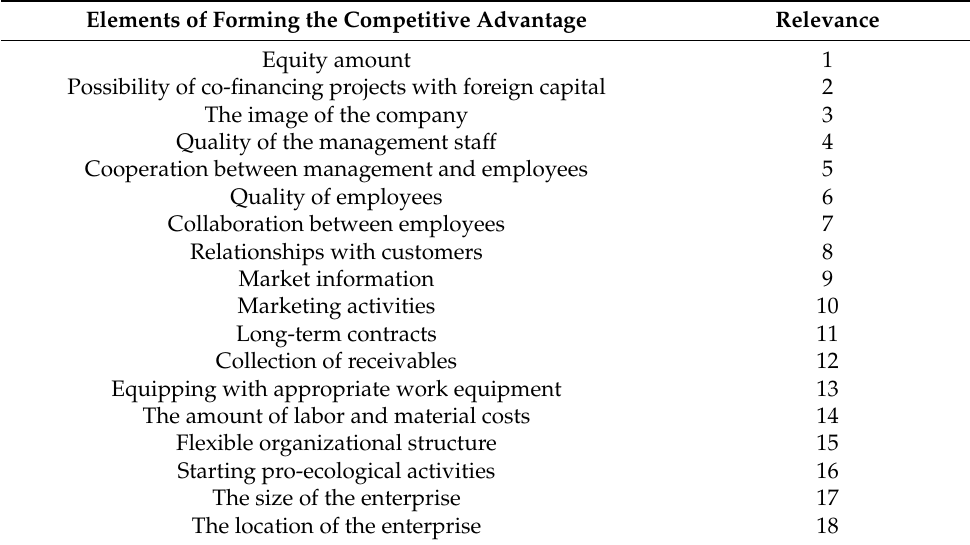
Table 3. Assessment of the significance of individual elements shaping the competitive advantage. Elements of Forming the Competitive Advantage Relevance Equity amount Possibility of co-financing projects with foreign